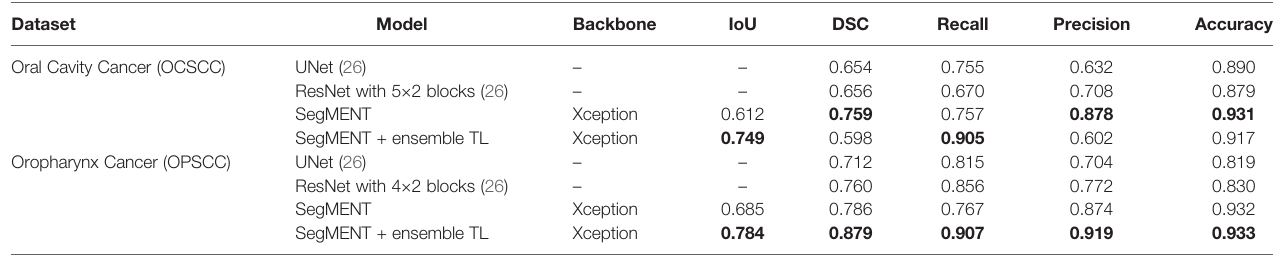
TABLE 3 | Performance evaluation of models during testing on the oral cavity (OCSCC) and oropharynx squamous cell carcinoma (OPSCC) datasets. Dataset